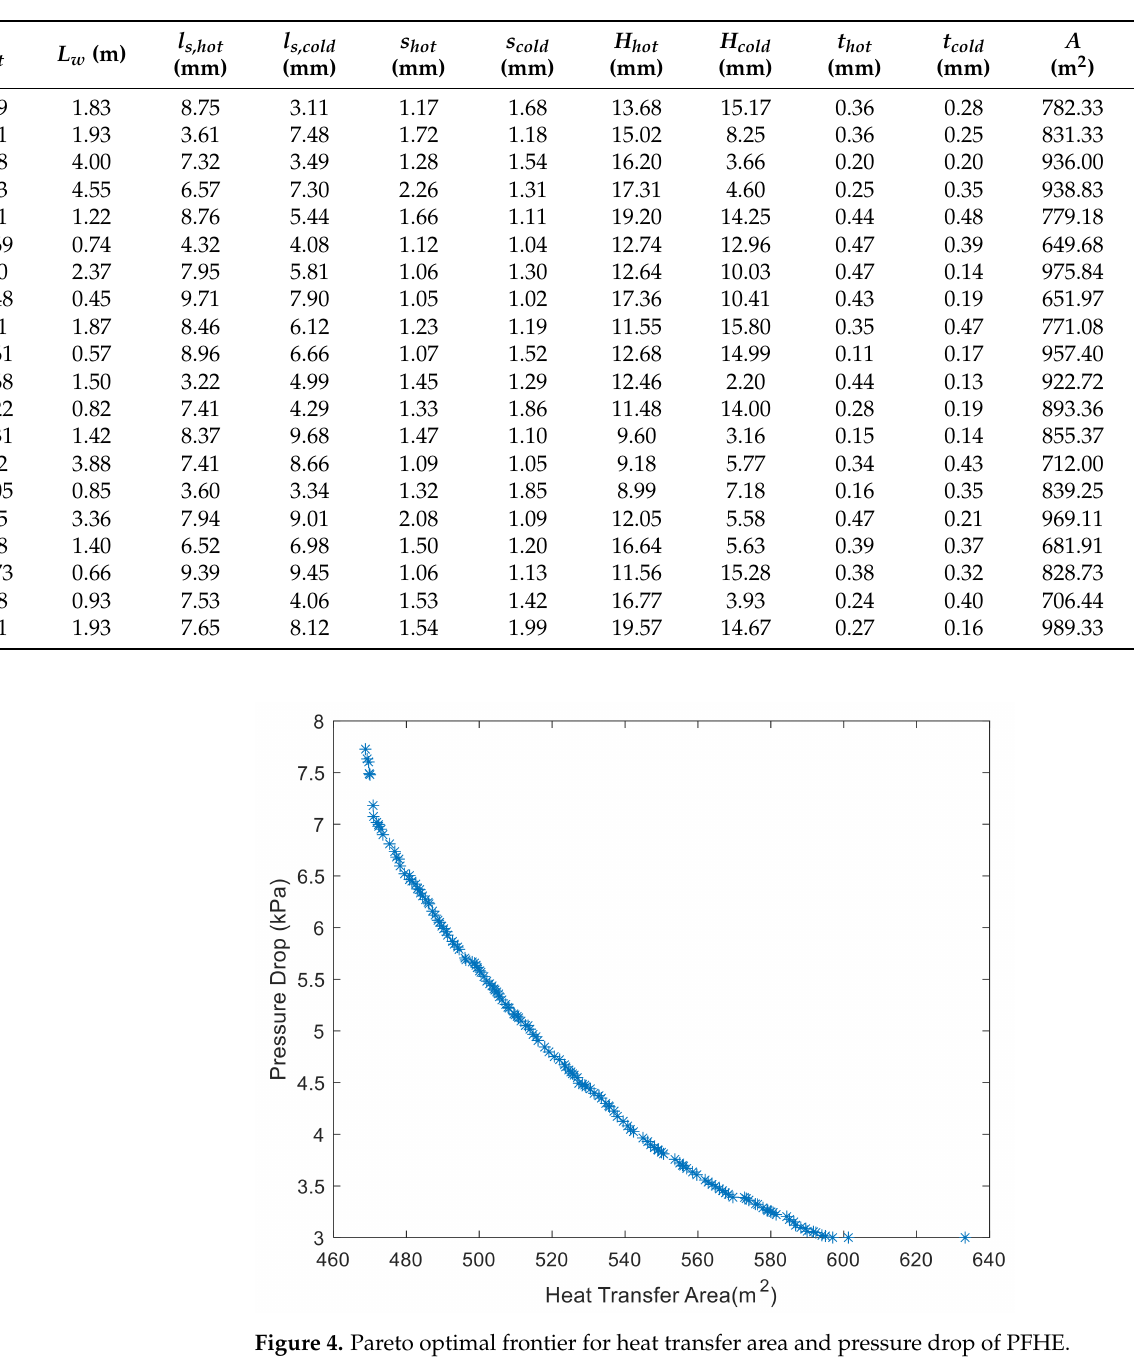
Table 3. Specific individuals in first generation.